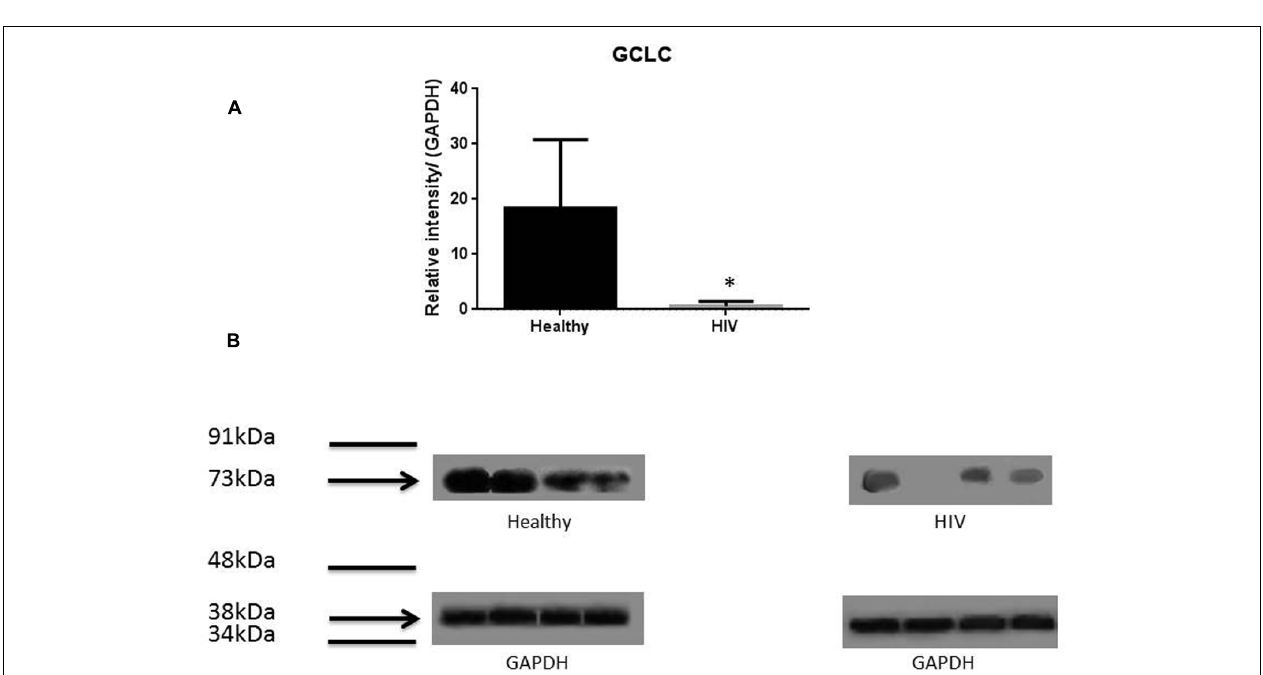
FIGURE 1 | Quantifying of GSS enzyme levels in Healthy and HIV-infected subjects. Red blood cell samples were separated from blood of healthy volunteers and HIV-infected individuals were used for measurement of GSS, the enzyme that is involved in the second step of GSH synthesis. Electrophoresis and Western blot were used. There was a significant decrease of GSS in the RBC of HIV-infected individuals